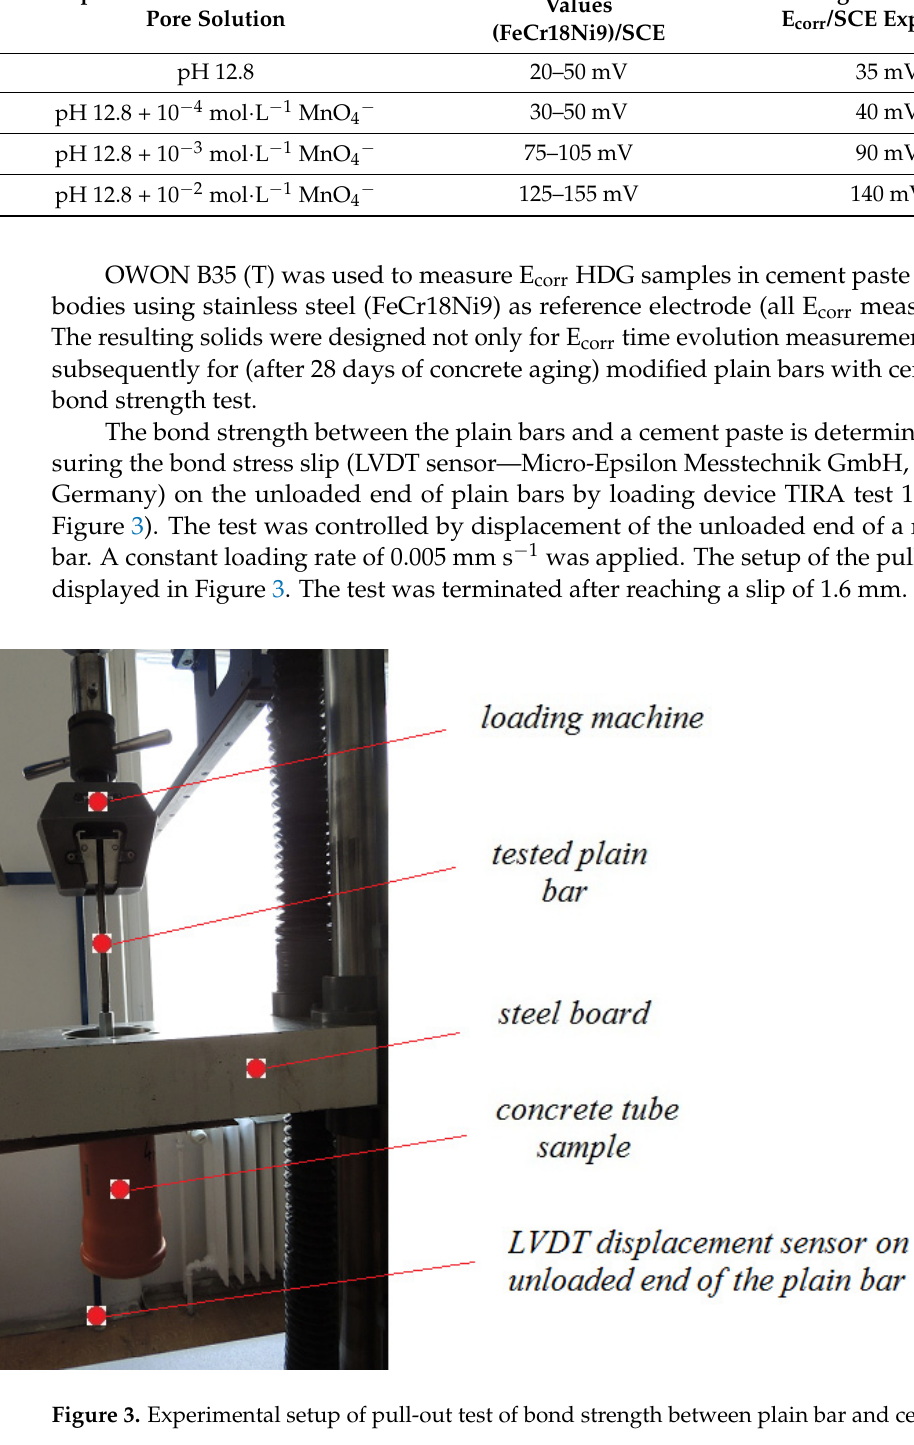
Table 6. Composition of plain bar steel 10216